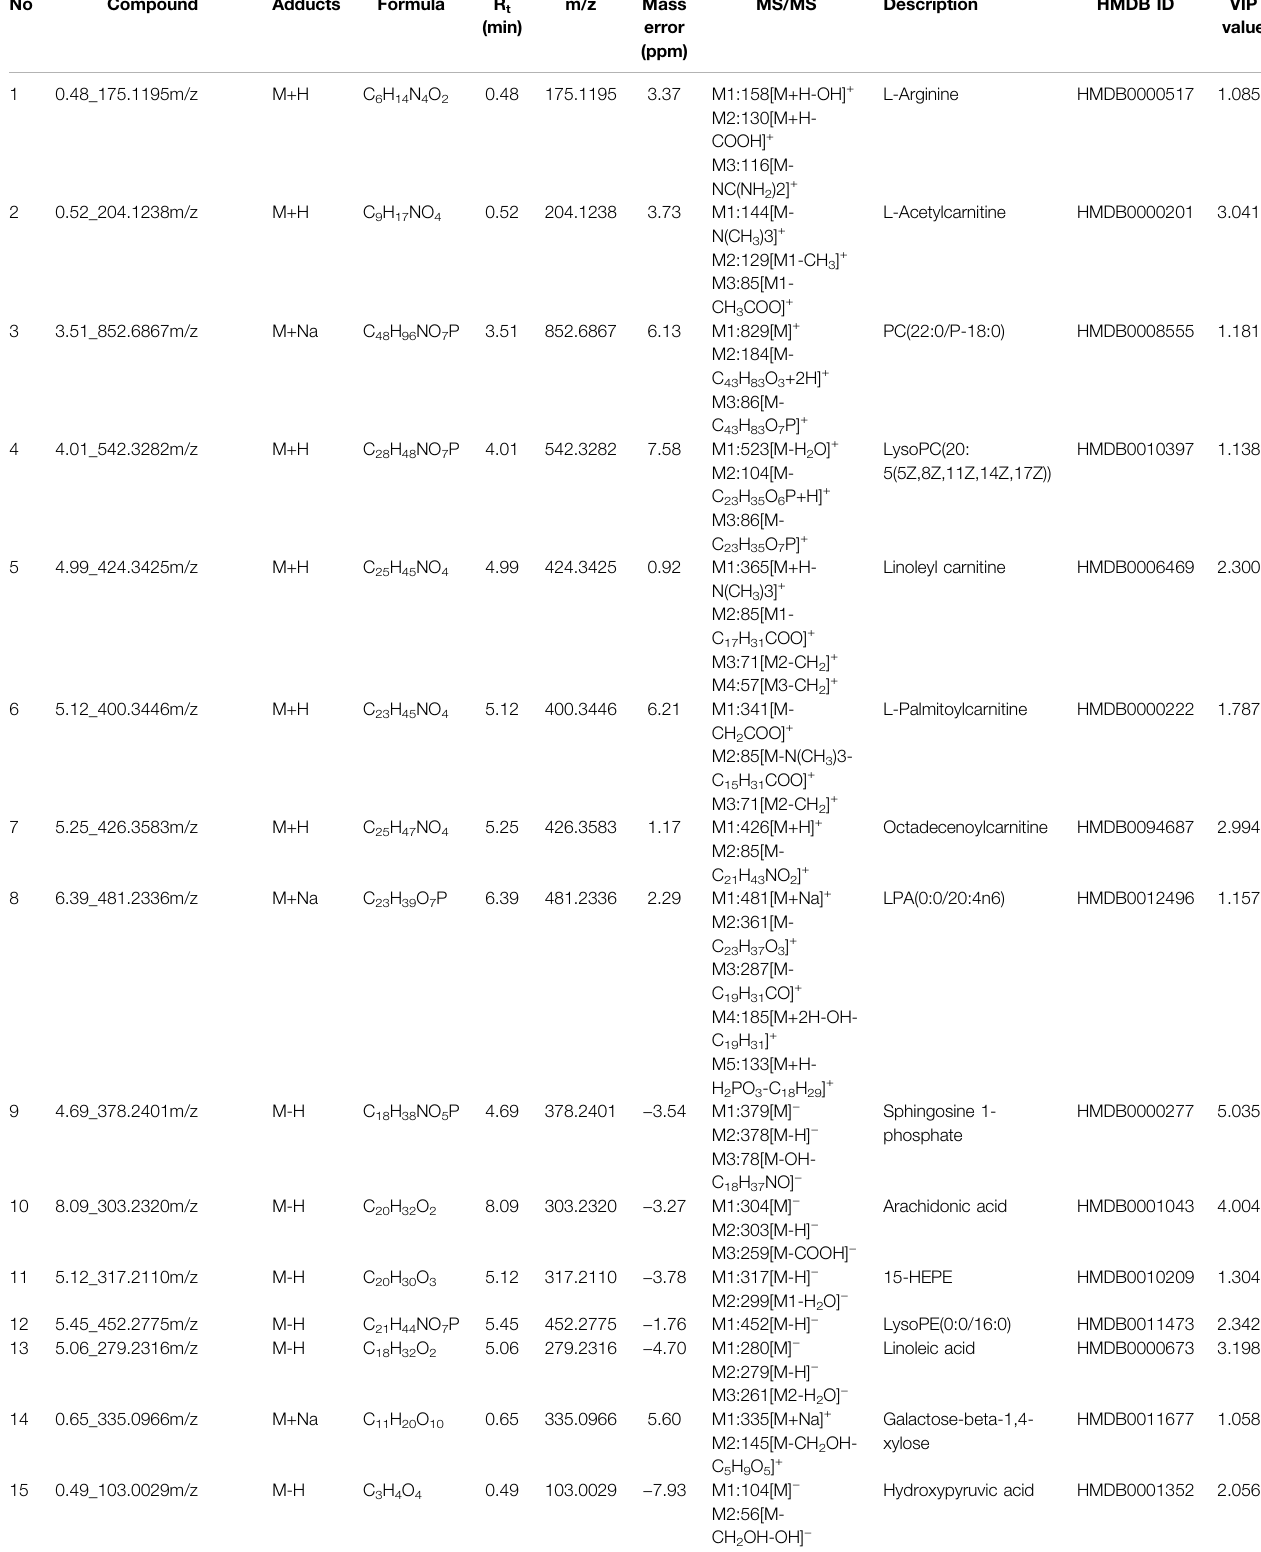
TABLE 1 | Identi fi cation results of potential biomarker groups in adjuvant-induced arthritis